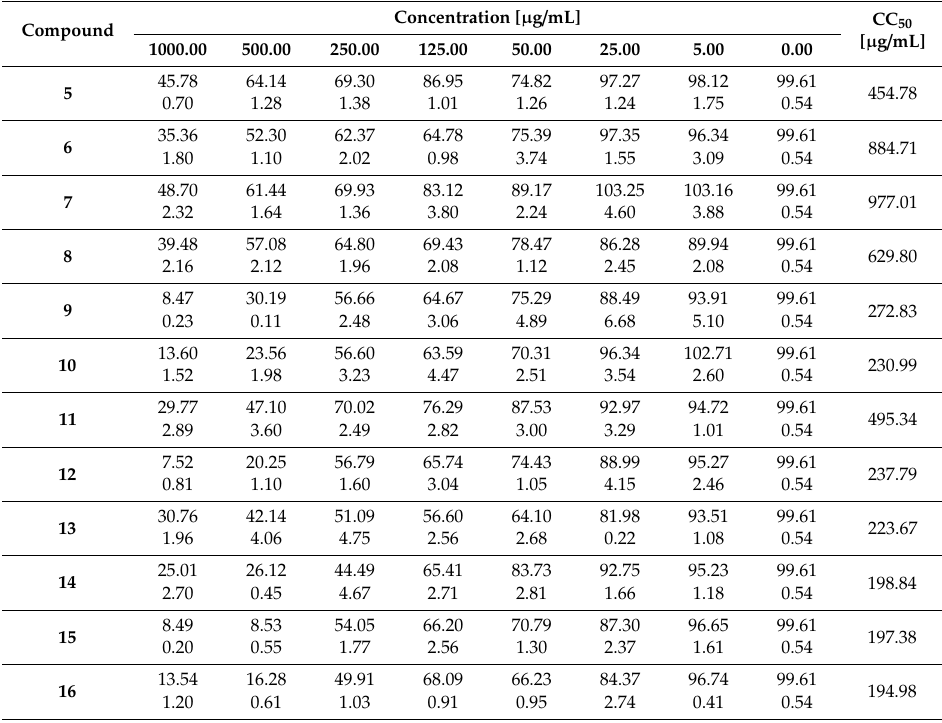
Table 1. The viability of L929 cells (in % of viable L929 cells ± standard deviation (SD)) in the concentration range of 5 – 16 between 0 to 1000 µg/mL.